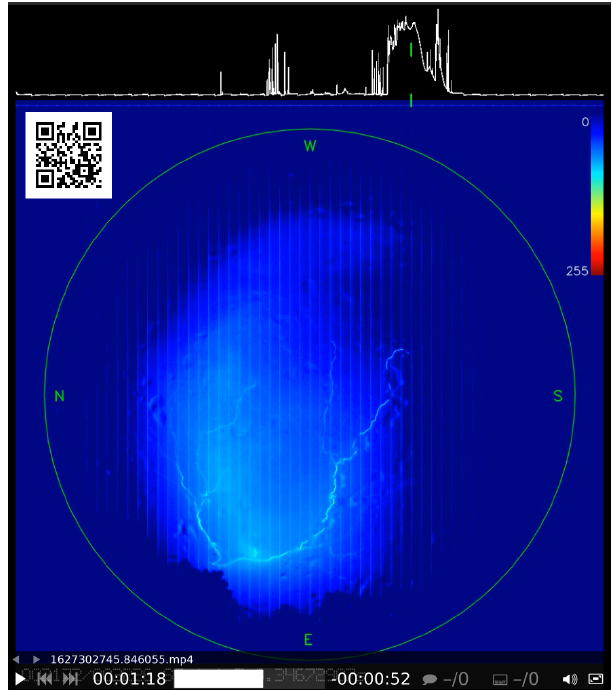
+ 0 . 27 s to T = + 0 . 40 s; https://av.tib.eu/media/60390#t=1: